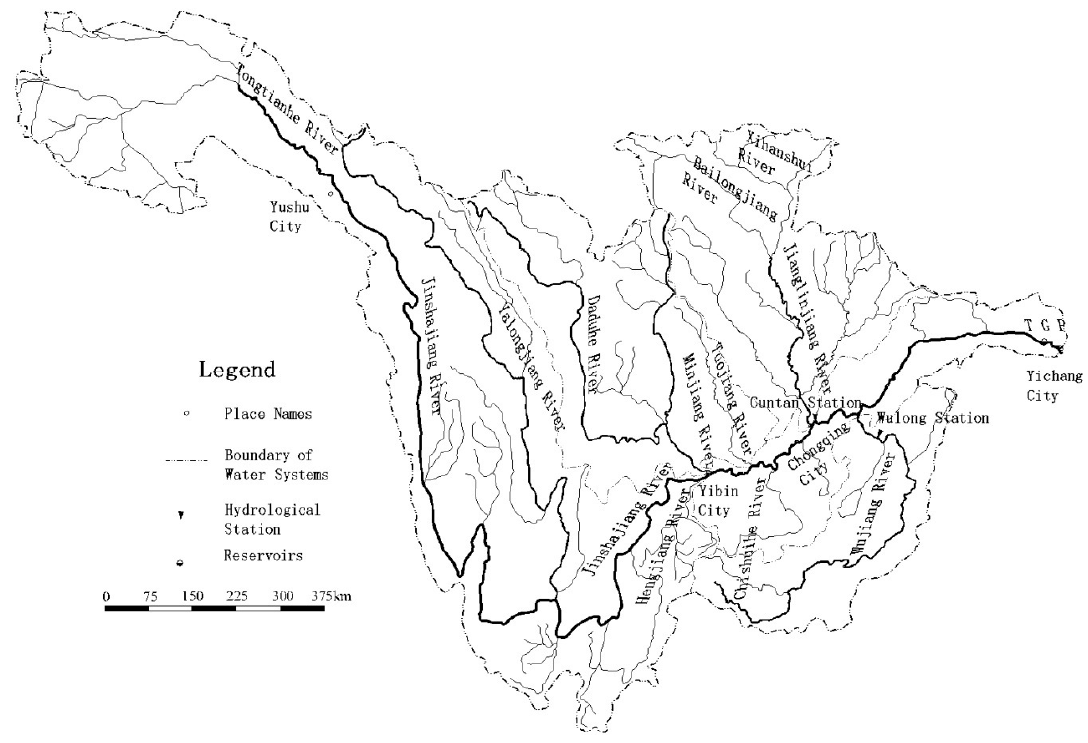
Figure 1. River system diagram of the upper reaches of the Yangtze River.